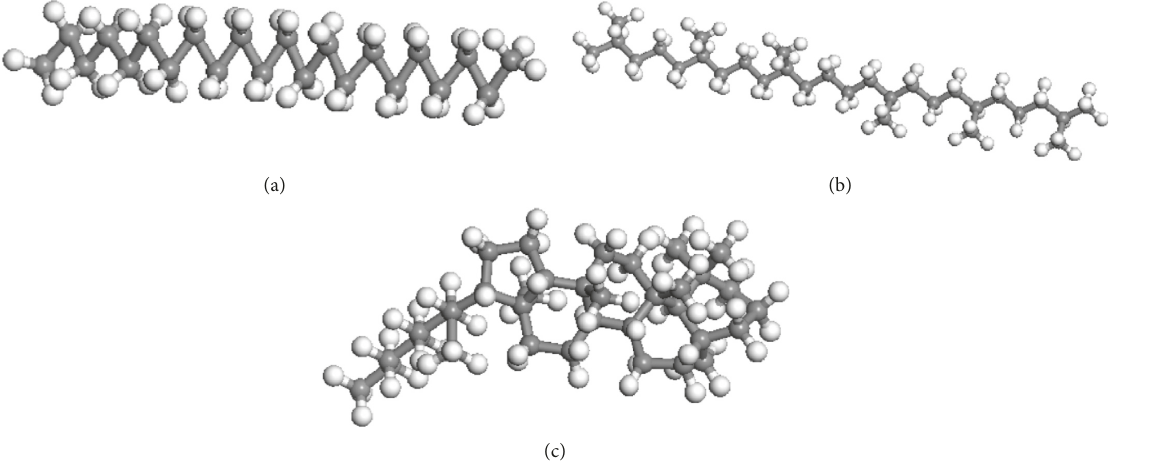
Figure 4: Typical molecular structures for aliphatics